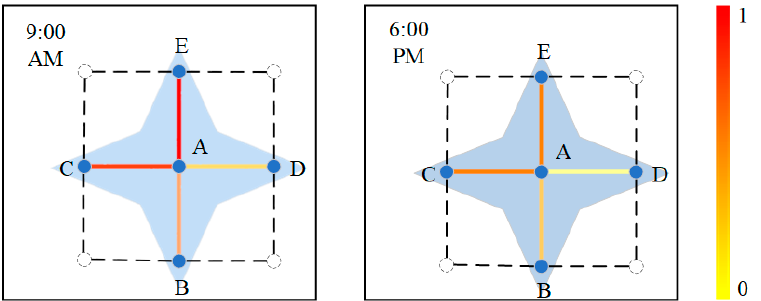
Figure 1. Spatial dependency diagram for network traffic.